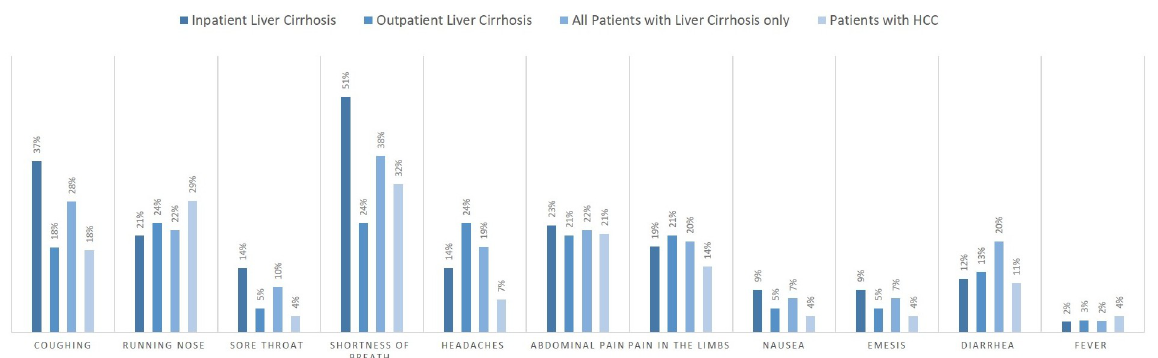
Fig 2. Distribution and frequency of clinical symptoms at baseline. Shortness of breath was the most frequent symptom in all patients, while sore throat (10%) and fever (2%) were only present in a minority of patients.